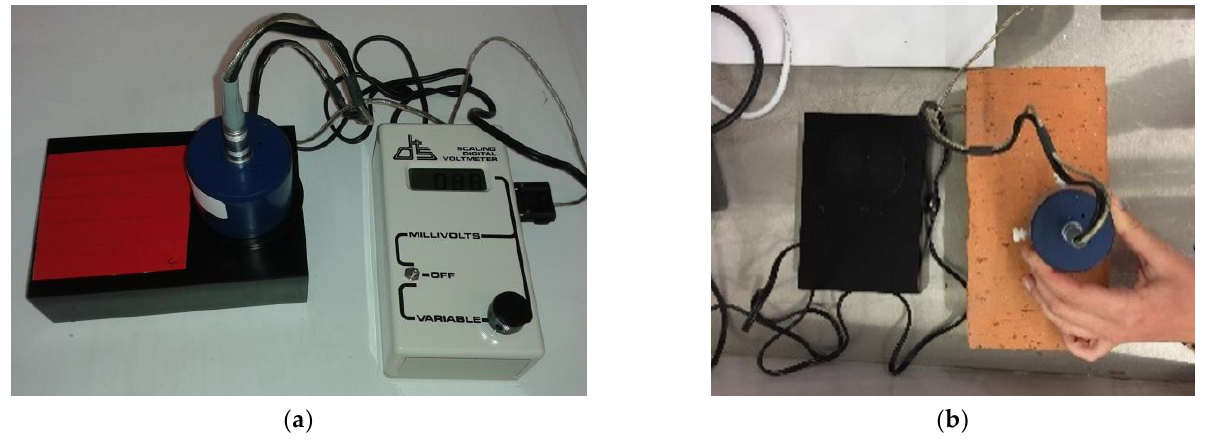
Figure 1. Test set up to assess the emissivity using the emissometer: ( a ) task T.Ia; ( b ) tasks T.II and T.III.